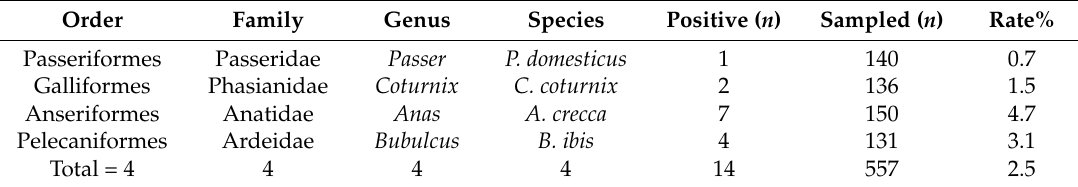
Table 2. Proportion of sampled wild birds across different Egyptian provinces.